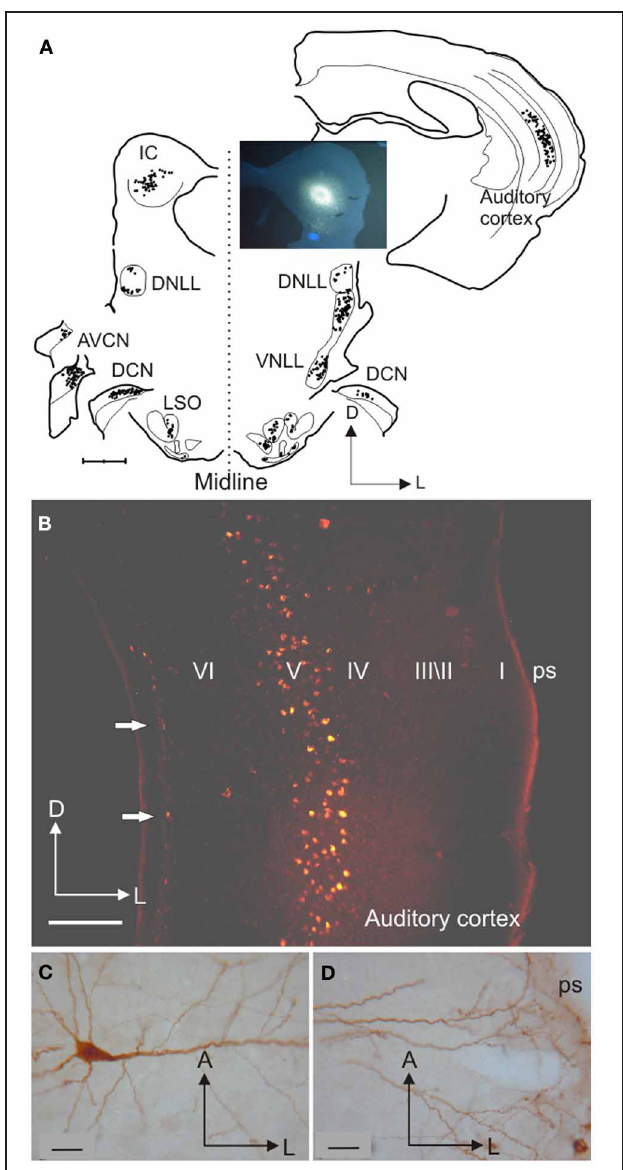
FIGURE 1 | Inputs from different auditory centers converge in the IC. (A) A small fluorogold tracer injection in the ventromedial part of the IC central nucleus of the gerbil produces retrograde labeling of neurons in the MSO, periolivary nuclei, VNLL, and A1 on the same side, in the cochlear nuclei and IC on the opposite side, and in the LSO, DCN, and DNLL on both sides. (B) Retrogradely labeled cells in the cortex are found mainly in layer V after a rhodamine tracer injection in the IC. (C) Large labeled pyramidal cell with the soma located in cortical layer V and (D) a tufted dendritic tree ending in layer I. Calibration bars: 1mm (A) , 0.2mm (B) , and 25 µ m (C,D) . Modified with permission from Bajo and Moore